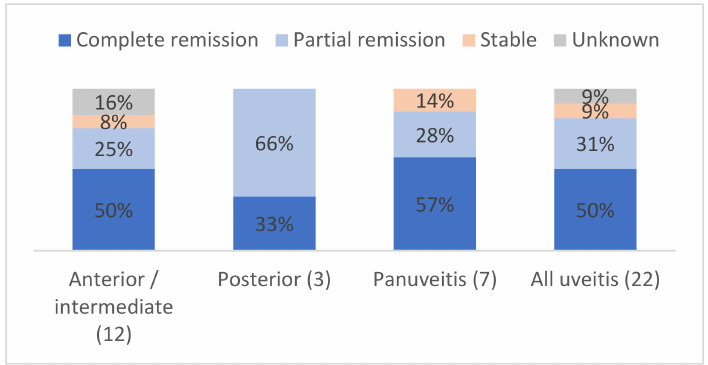
Figure 2. Ocular outcomes depending on the type of uveitis, in